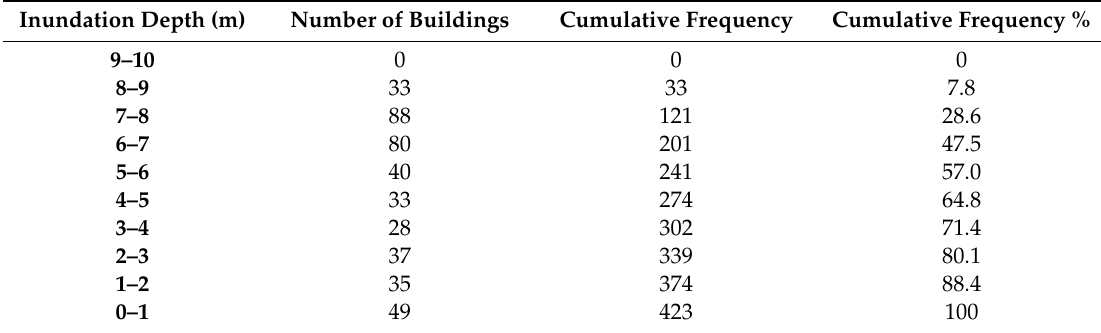
Table 1. Number of buildings per inundation depth.